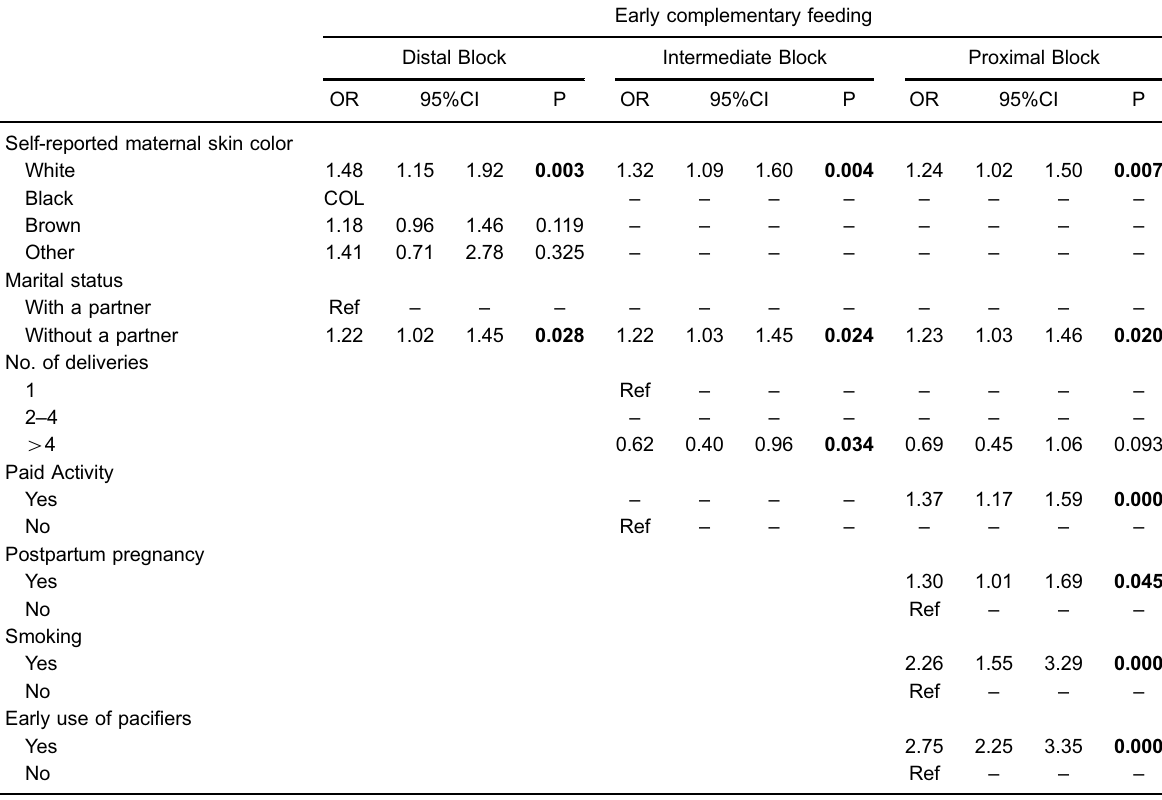
Table 3. Hierarchical theoretical model of statistically signi fi cant variables associated to early complementary feeding in São Luis, MA, Brazil, 2010 –